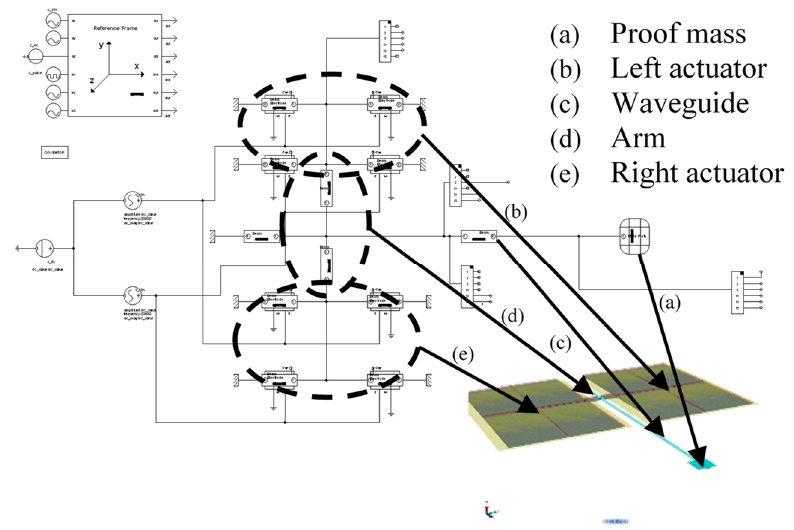
Figure 5. The 3D physical geometry of the scanner mapped to the corresponding behavior symbols.